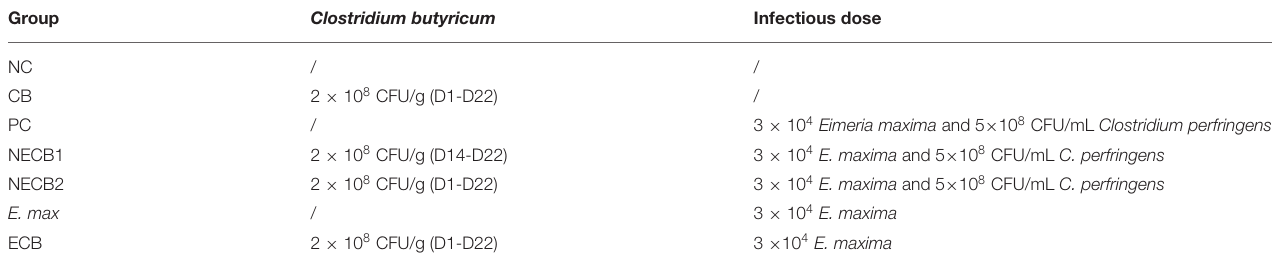
TABLE 2 | Experimental design. Group Clostridium butyricum Infectious